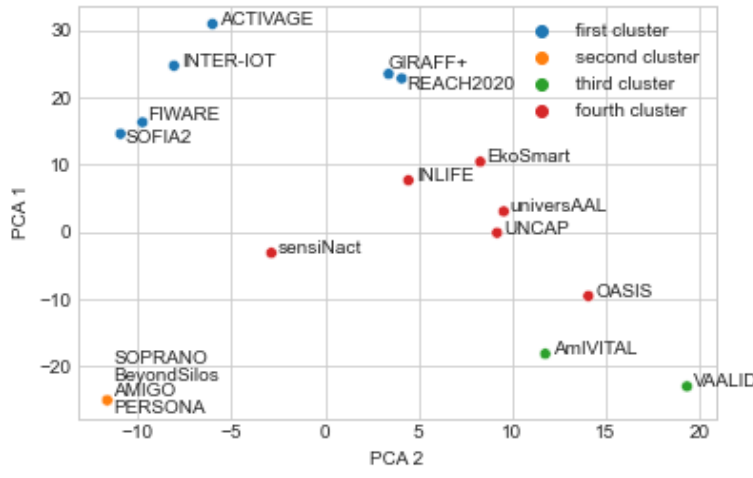
Figure 4. Result of k-means with four clusters and non-standardized input